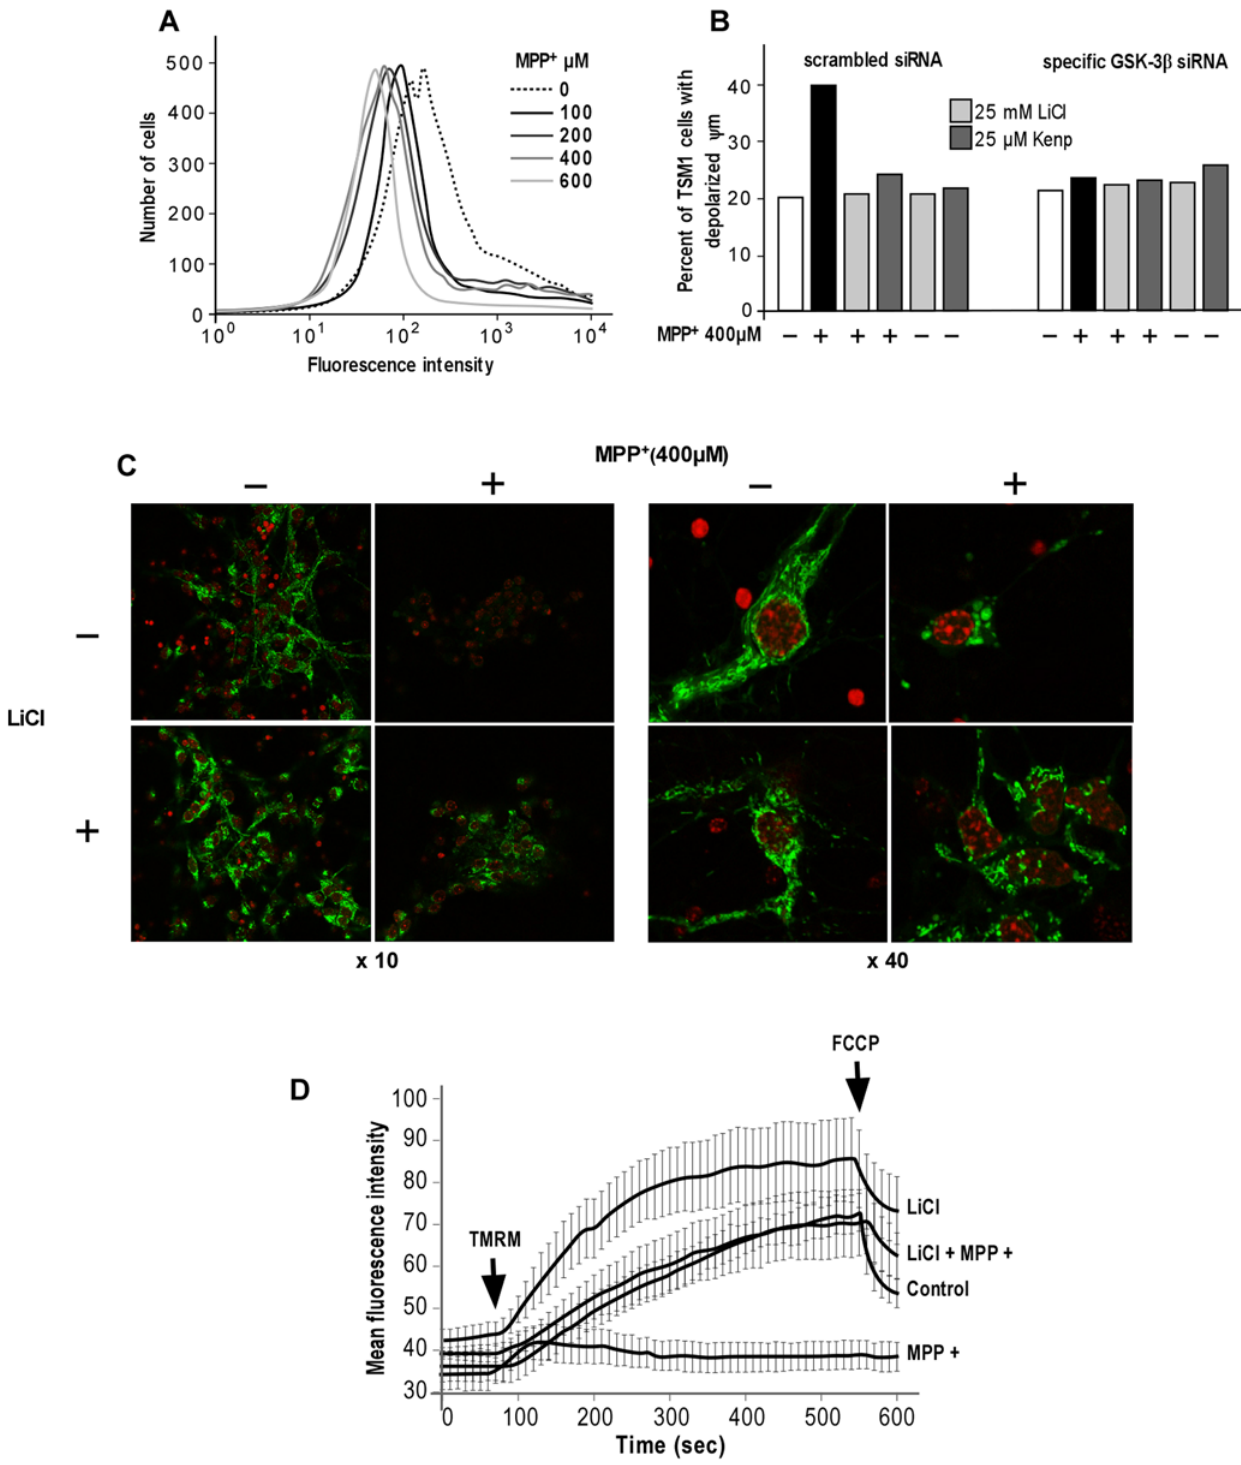
Figure 5. GSK-3 b contributed to MPP + -induced TSM1 neuronal cell death through alterations of the mitochondrial membrane potential. (A) TSM1 neurons were treated with the indicated concentrations of MPP + for 8 h then cells were stained with JC-1 and analyzed by flow cytometry. (B) TSM1 cells were cultured for 24 h then transfected with scrambled or GSK-3 b -specific siRNA (200 nM). Two days post-transfection, cells were pre-treated with saline buffer or 25 mM LiCl or 25 m M kenpaullone ( kenp ), then co-incubated or not with MPP + (400 m M) for 8 h. Cells were stained with JC-1 as described in Materials and Methods and prepared for flow cytometry analysis. The results are expressed as the percent of cells with depolarized mitochondrial membrane potential ( Y m). (C, D) intact primary neurons were pre-treated of not with 25 mM LiCl, then co-incubated or not with MPP + (400 m M) for 4 h. Cells were placed on the stage on a laser-scanning confocal microscope and images were collected every 10 seconds for 10 minutes. One minute after the beginning of experiment, neurons were loaded with 30 nM TMRM (arrow) and one minute before